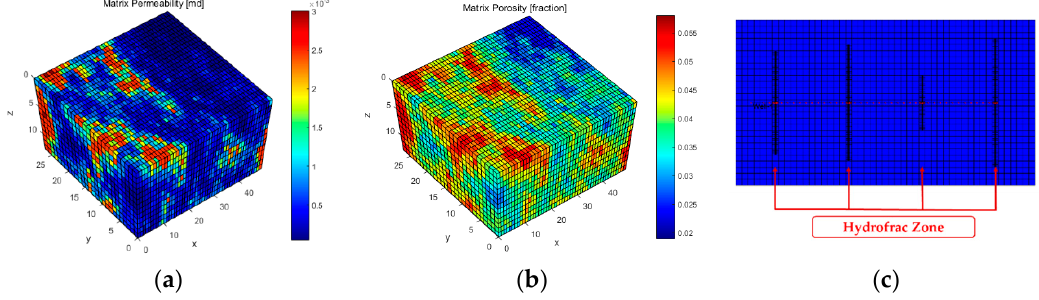
Figure 5. Shale gas reservoir in 3D grid systems—( a ) matrix permeability, ( b ) matrix porosity, and ( c ) hydraulic fracturing design. Table 1. Input properties of the synthetic reservoir to computing the proxy modeling.